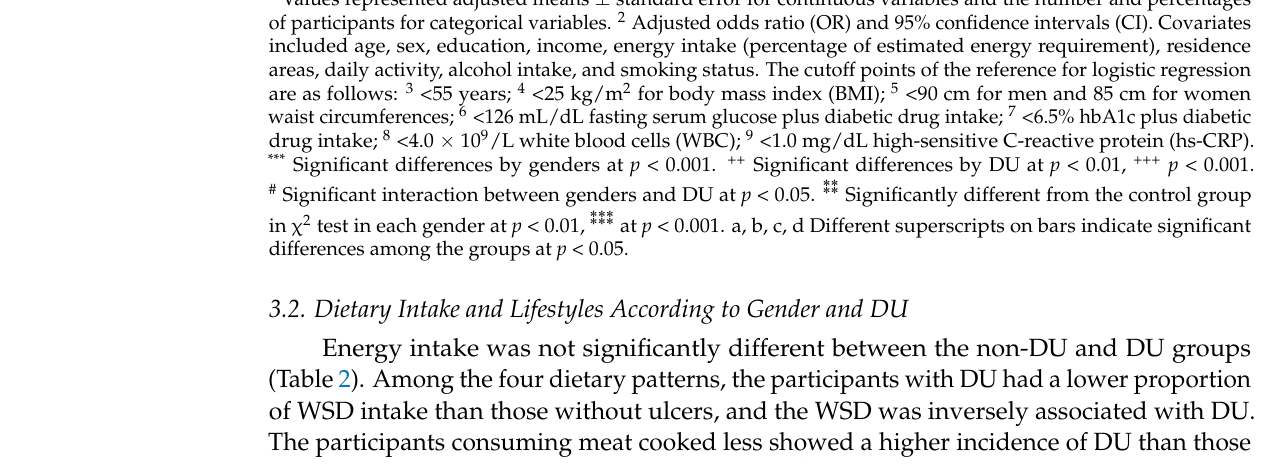
Table 1. General characteristics of the participants according to gender and duodenal ulcer.